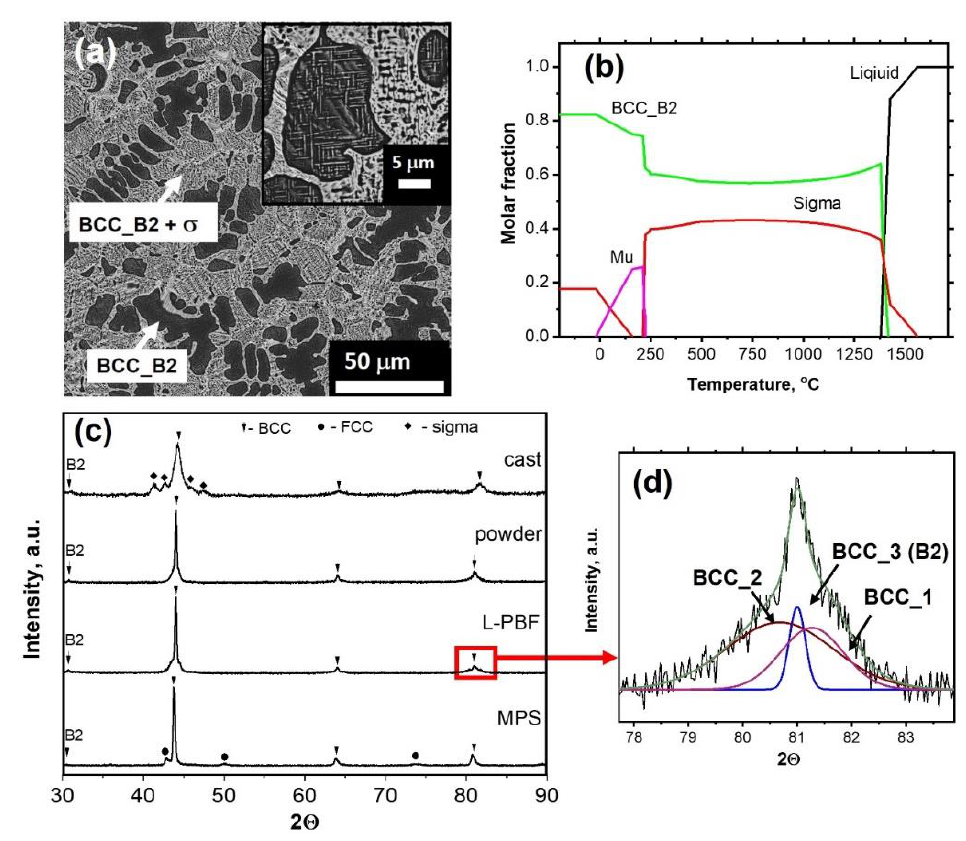
Figure 2. Microstructure of the cast alloy ( a ), equilibrium phases in dependence on the temperature calculated by Thermo- Calc ( b ), XRD patterns of the cast alloy, powder, L-PBF, and MPS fabricated samples ( c ), demonstration of XRD peak deconvolution ( d ).